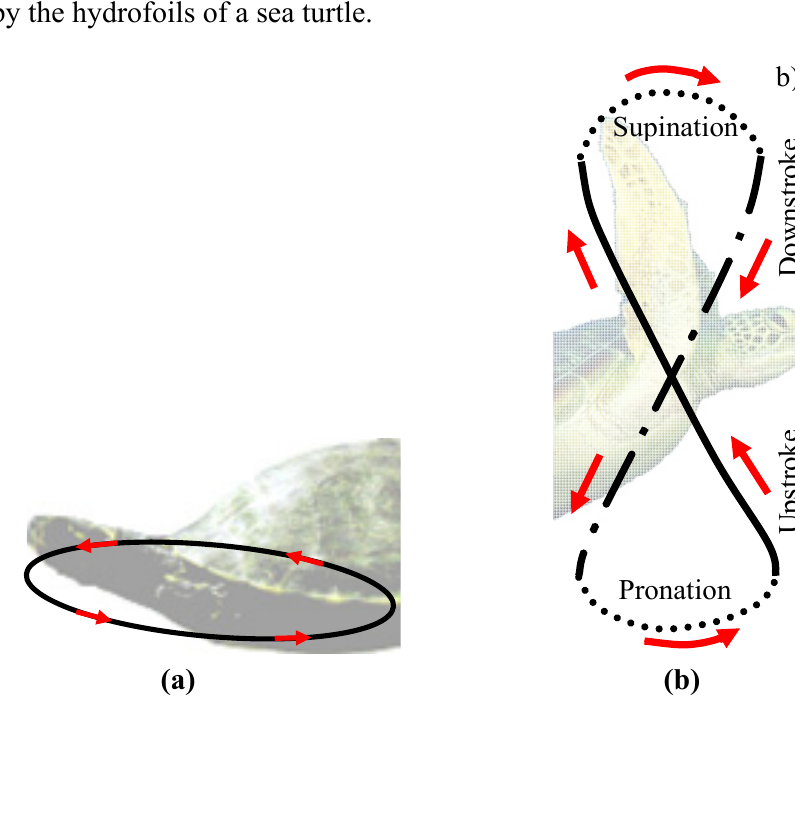
Figure 1. (a) Oval path followed by the legs of a freshwater turtle. (b) Figure-of-eight path followed by the hydrofoils of a sea